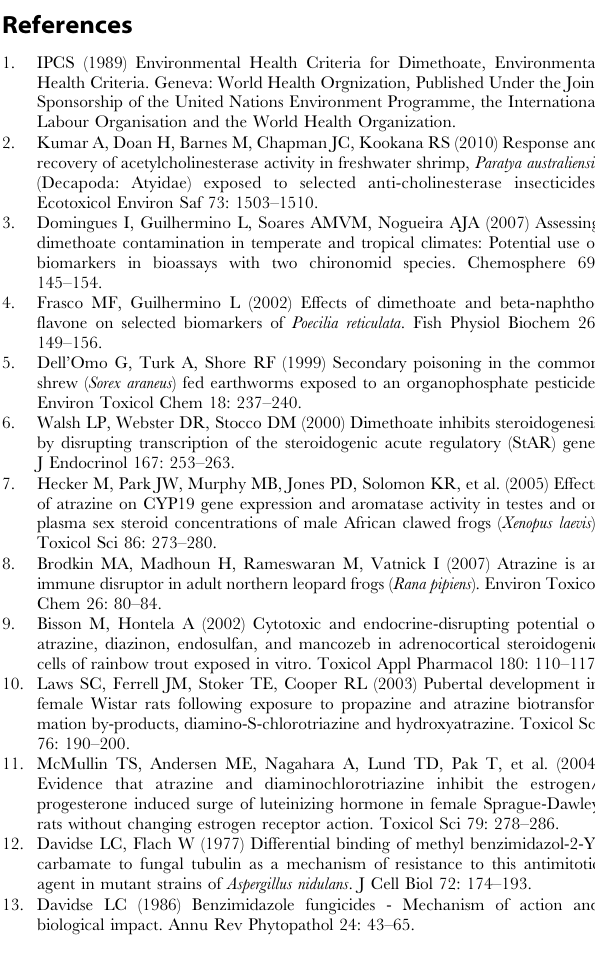
Table S4 Significant differentially expressed tran- scripts in Enchytraeus albidus with significant blast homologies, present in the following lists of differen- tially expressed genes: 1) uniquely affected by dimethoate; 2) uniquely affected by atrazine; 3) uniquely affected by carbenda- zim; 4) affected by dimethoate and atrazine; 5) affected by dimethoate and carbendazim; 6) affected by atrazine and carbendazim; 7) affected by the three pesticides. Table S5 All significant differential expressed genes of the significant ( p , 0.05) gene ontology (GO) terms in Enchytraeus albidus , in each of the following lists: 1) uniquely affected by dimethoate; 2) uniquely affected by atrazine; 3) uniquely affected by carbendazim; 4) affected by dimethoate and atrazine; 5) affected by dimethoate and carbendazim; 6) affected by atrazine and carbendazim; 7) affected by the three